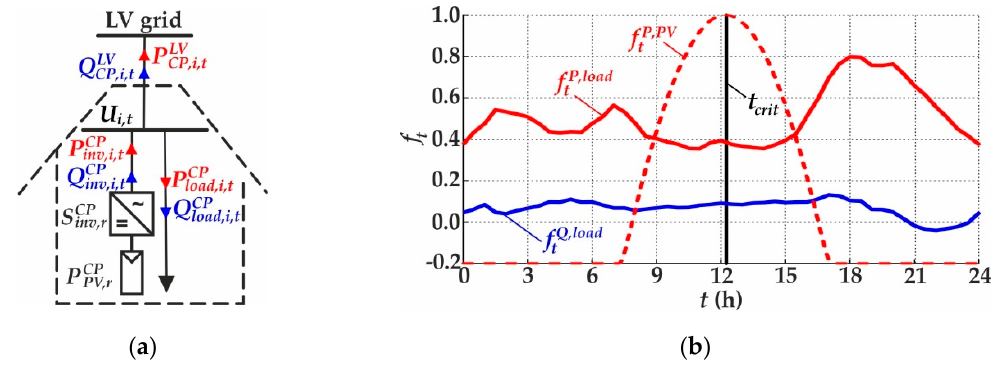
Figure 2. Customer plant model: ( a ) structure; ( b ) load and production profiles.